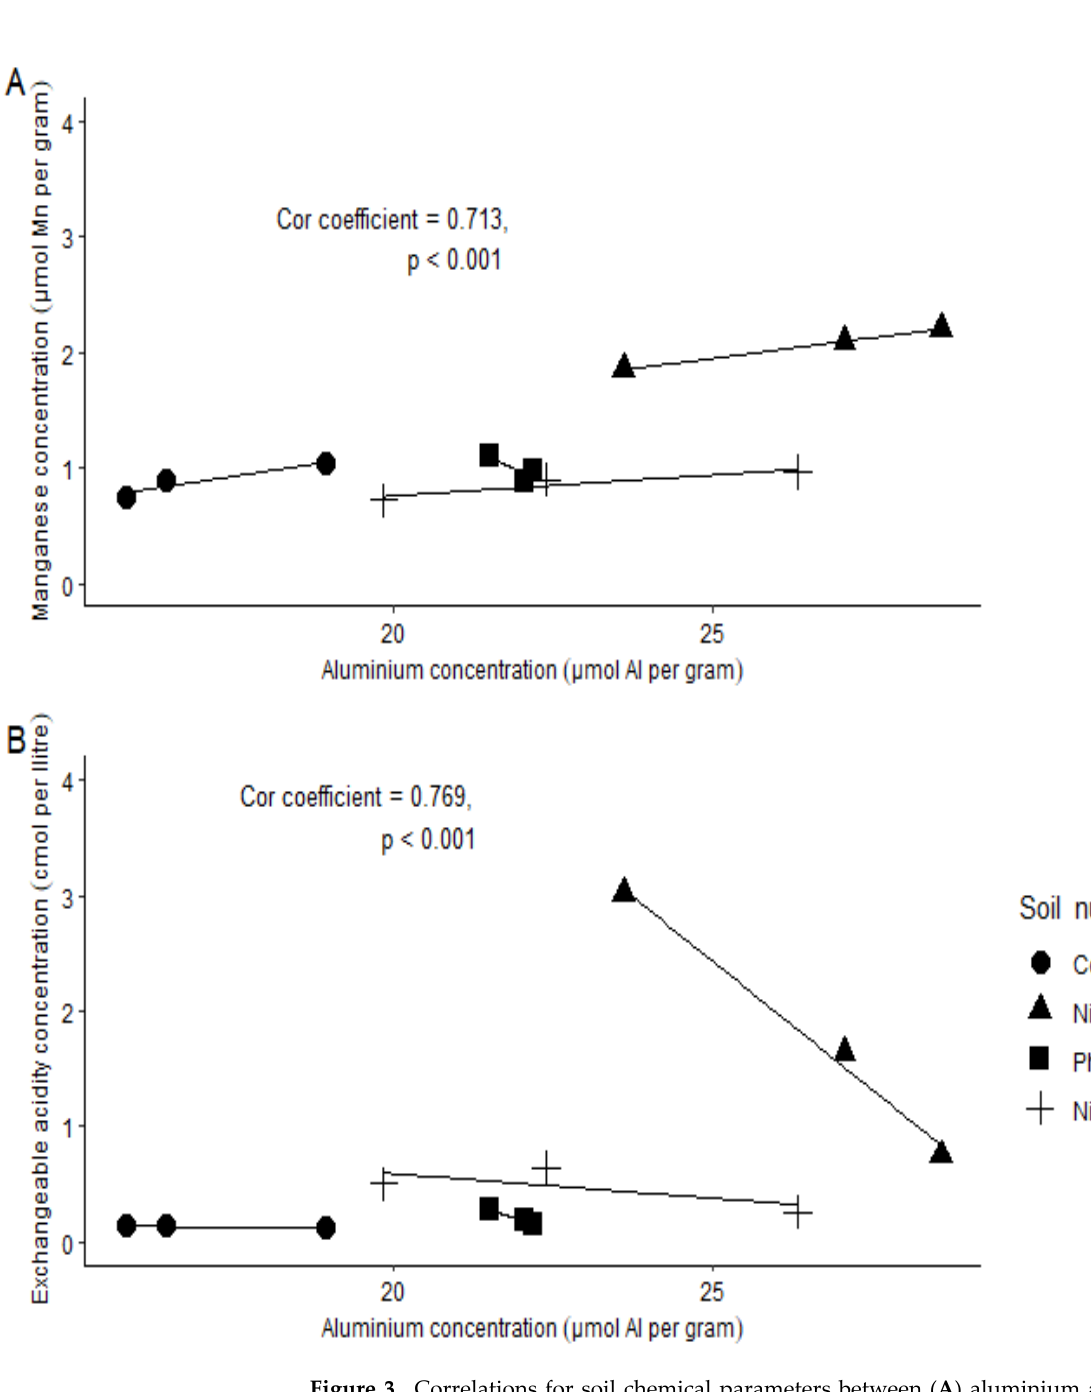
Figure 3. Correlations for soil chemical parameters between ( A ) aluminium and manganese con‑ centrations and ( B ) aluminium and exchangeable acidity. Spearman’s correlation coefficient > 0.700 and p < 0.05 is shown here. Key: • = control (no nutrients added); ■ = phosphorus‑enriched soils; ▲ = nitrogen‑enriched soils and ₊ = nitrogen and phosphorus‑enriched soils.